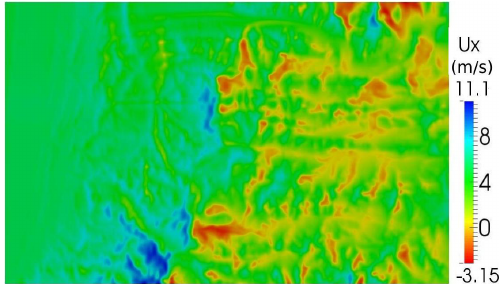
Figure 9. Wind speed in x -direction at 30 m.